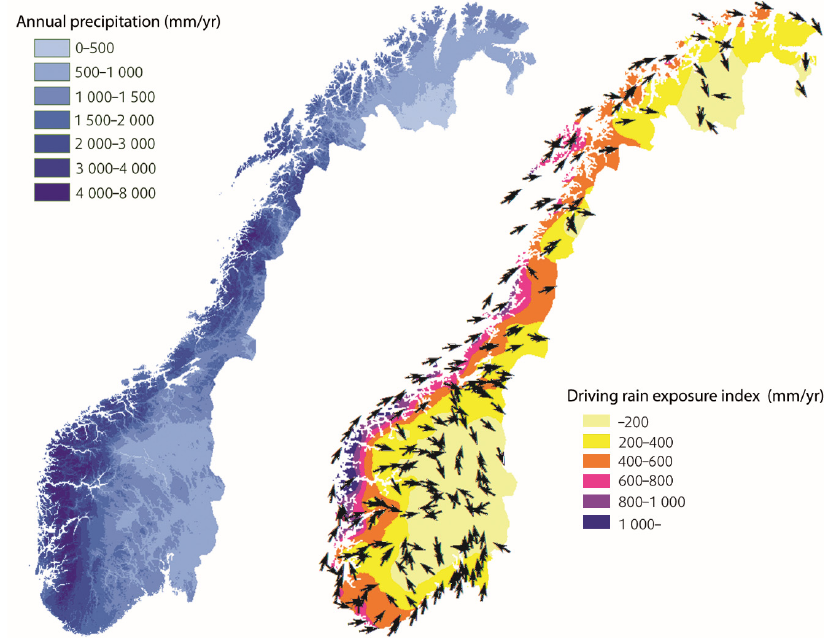
Figure 2. Annual precipitation and driving rain map of Norway for the normal period from 1961 to 1990. Raw data provided in